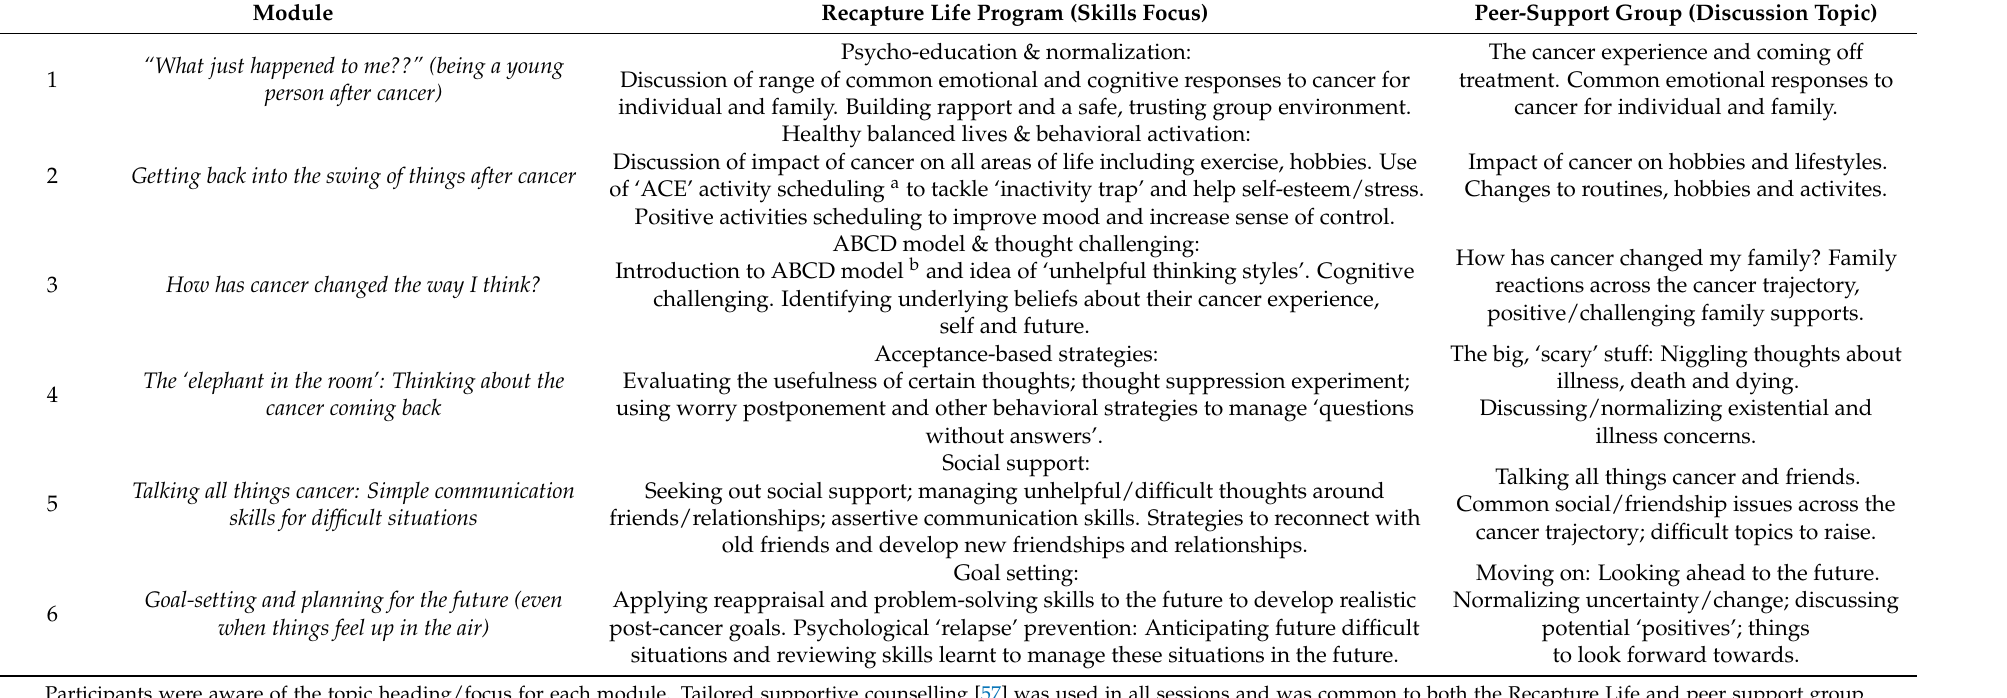
Table 1. Recapture Life and peer-support control group weekly content delivered by the psychologist during each